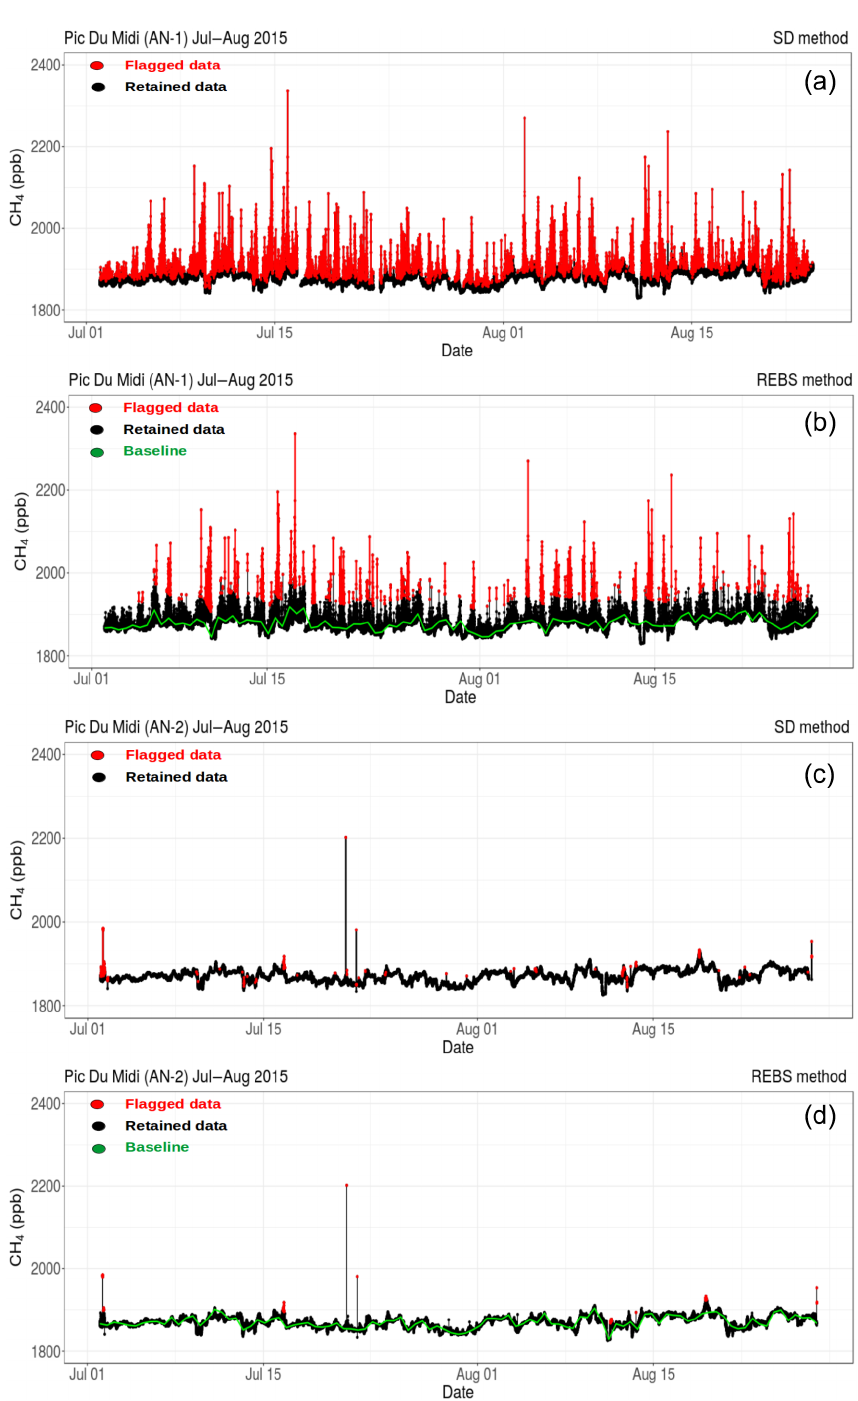
Figure 3. AN-1 CH 4 measurement at T55 building in panels (a) and (b) and AN-2 TDF building in panels (c) and (d) . Black data points are the retained measurements; red points represent the flagged using SD method in panels (a) and (c) and REBS method in panels (b) and (d) .